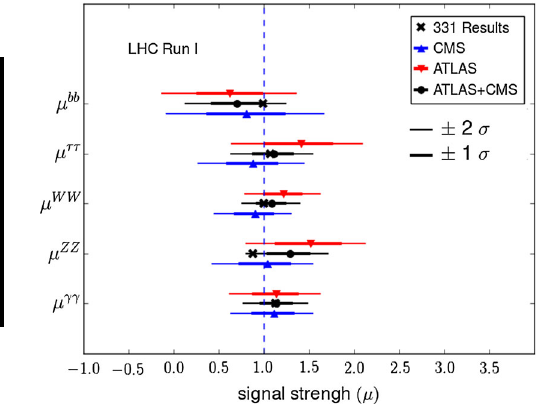
Fig. 5 Left:ThedominantbranchingratiosforourHiggs-likebosonas function of its mass. Right: Decay signal strengths taking into account the combination of ATLAS and CMS data. The error bars indicate the